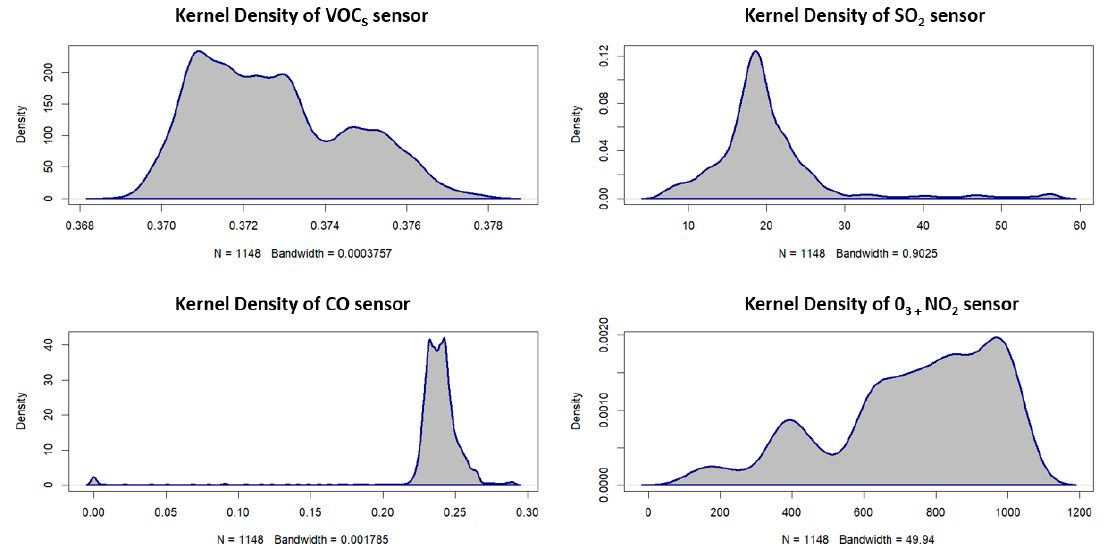
Figure A1. Kernel density for first ground measurement (VOCs sensor, SO 2 sensor, CO sensor, O 3 + NO 2 sensor).